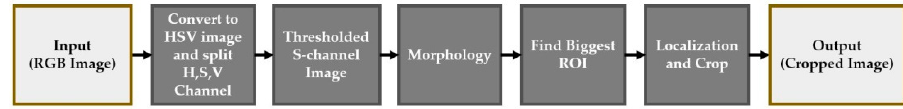
Figure 9. ROI extraction based on saturation channel information.